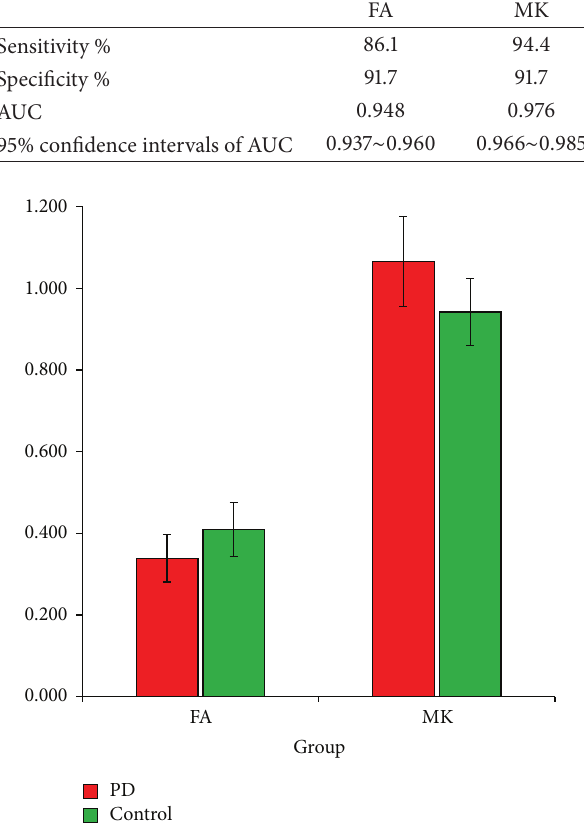
Figure 1: FA and MK in the SN of two groups. Mean FA and MK in bilateral rostral, middle, and caudal SN across patients with Parkinson disease (red) and control subjects (green).